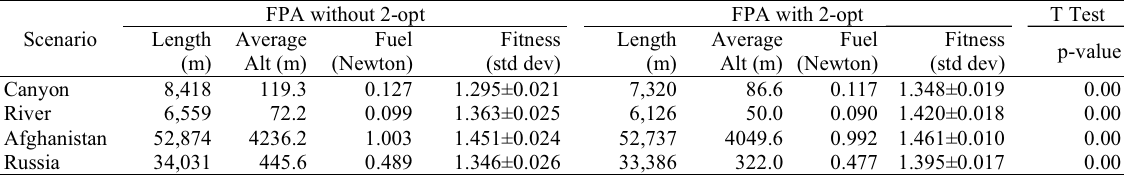
Table 4. Mean results of 50 trials for the FPA with and without 2-opt Scenario